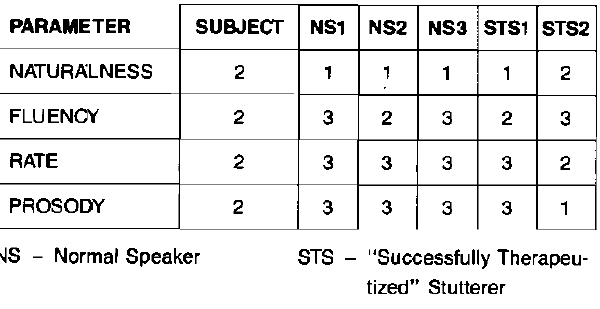
Table 2 Mean ratings of perceptual evaluation at relapse